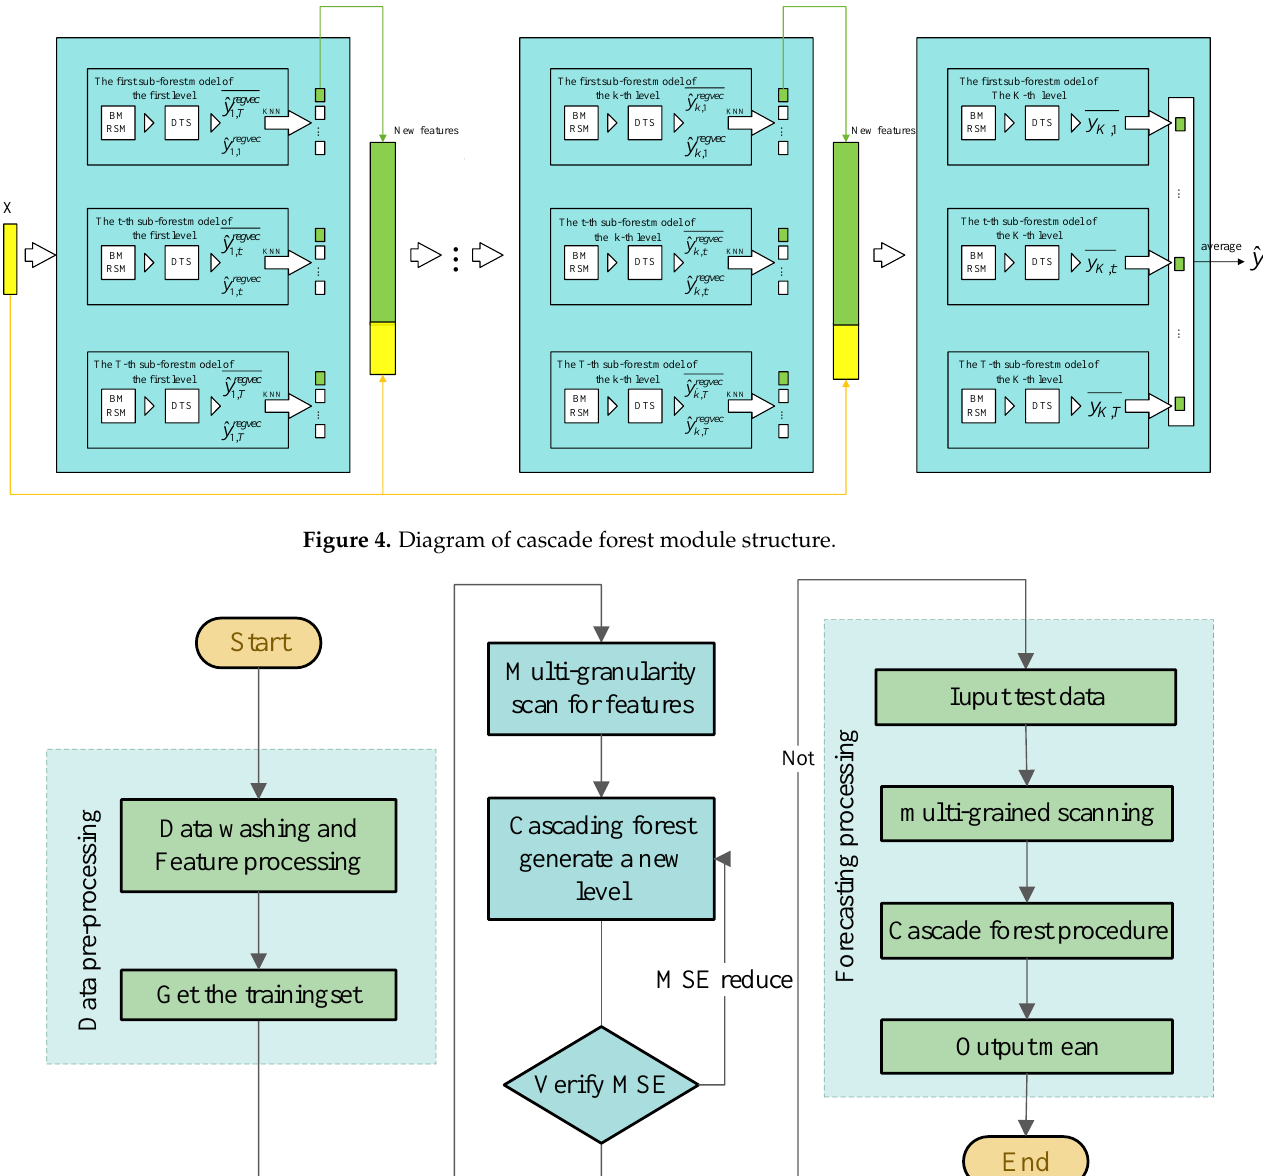
with each module consisting of two CRFs and RFs. The flow chart of the deep forest used in this study is shown in Figure 5.